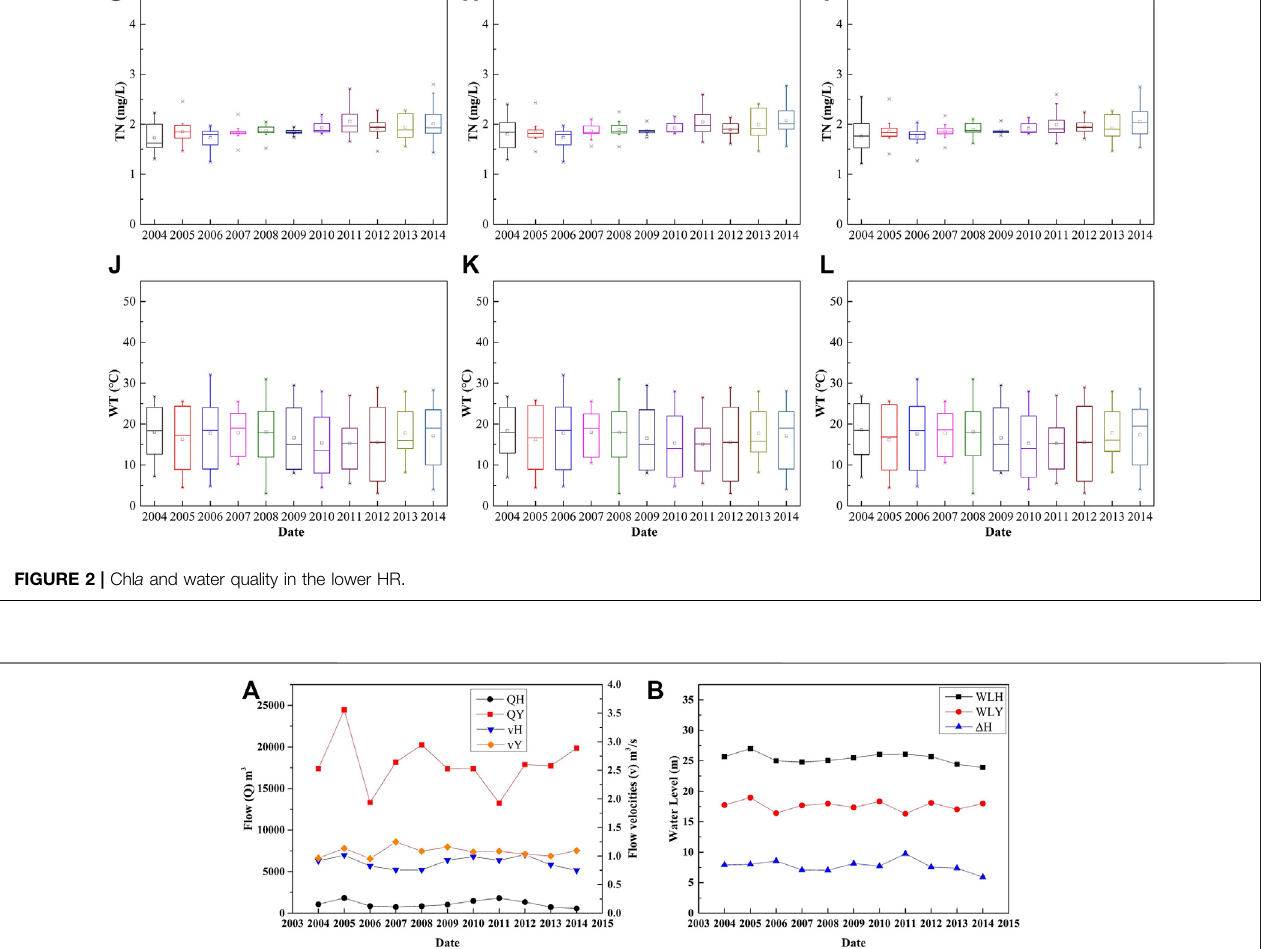
Frontiers in Earth Science |